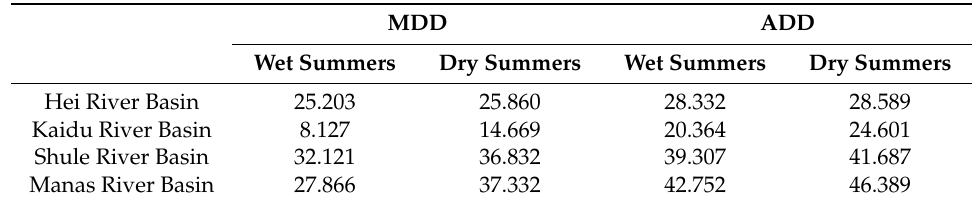
Table 9. Total contributions (%) of the temperature indices to the runoff indices—MDD and ADD—during wet and dry summers in studied basins.